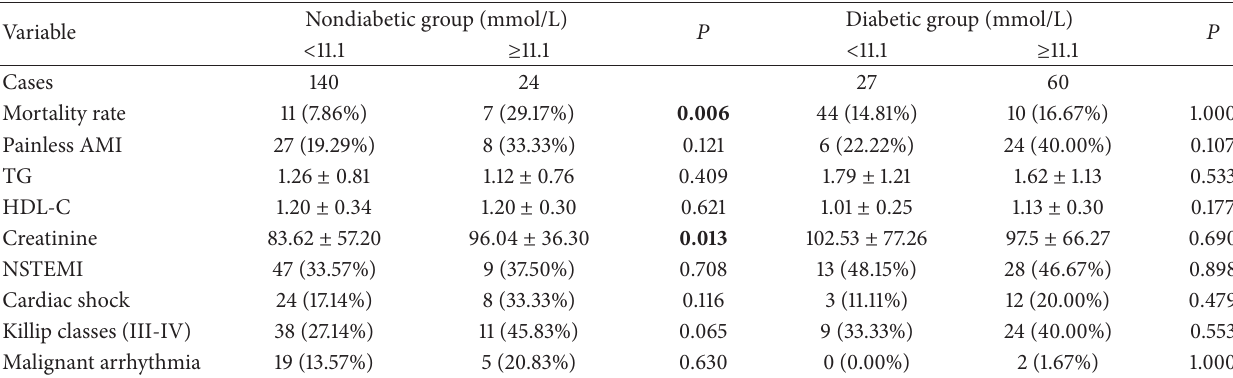
Table 2: Comparison of different admission glucose levels between nondiabetic group and diabetic